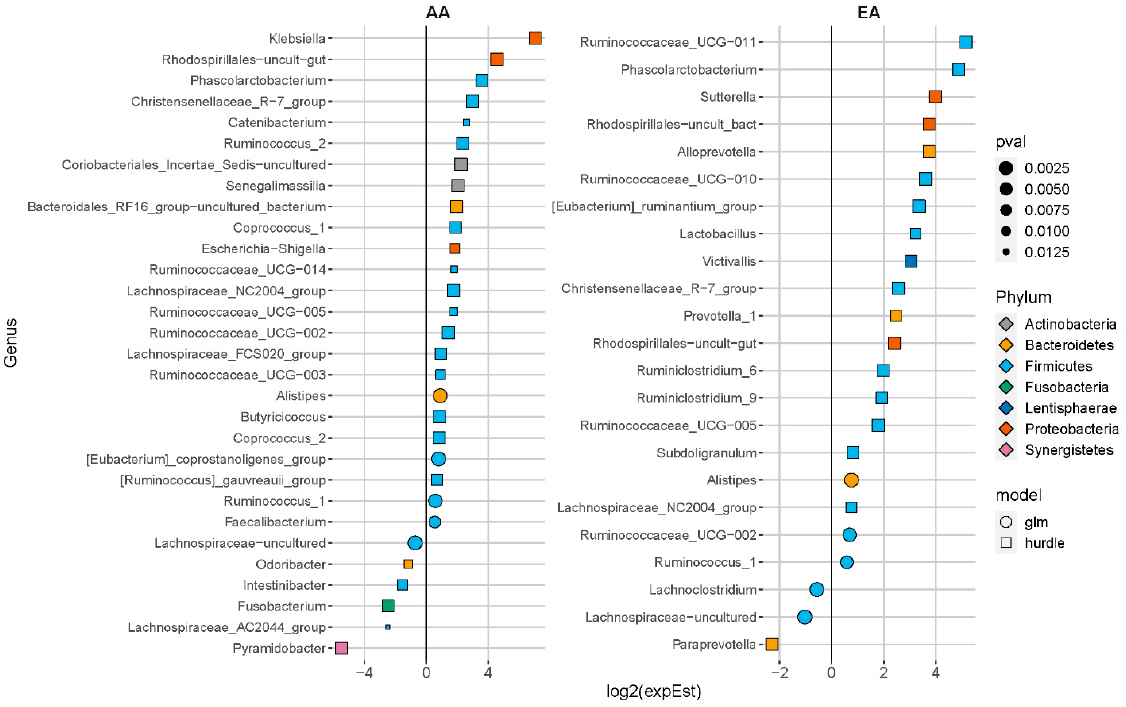
Figure 4. Differentially abundant genera associated with enterolactone (ENL) excretion after flaxseed (FS) intervention; padj < 0.05. Genera with less than 1% zeros across samples were fit with a negative-binomial generalized linear model (GLM) otherwise, a hurdle model was used. Models were adjusted for baseline age, body mass index (kg/m 2 ), total dietary fiber (g/d), energy intake (kcal/d), total FS consumption during the intervention period (g), and baseline ENL excretion.